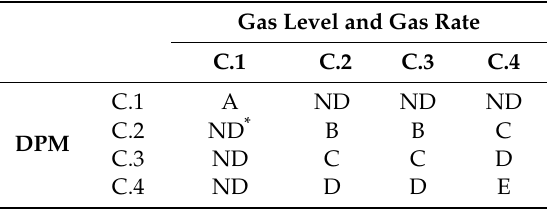
Table 12. Norm of faults’ severity based on DPM, gas level, and gas